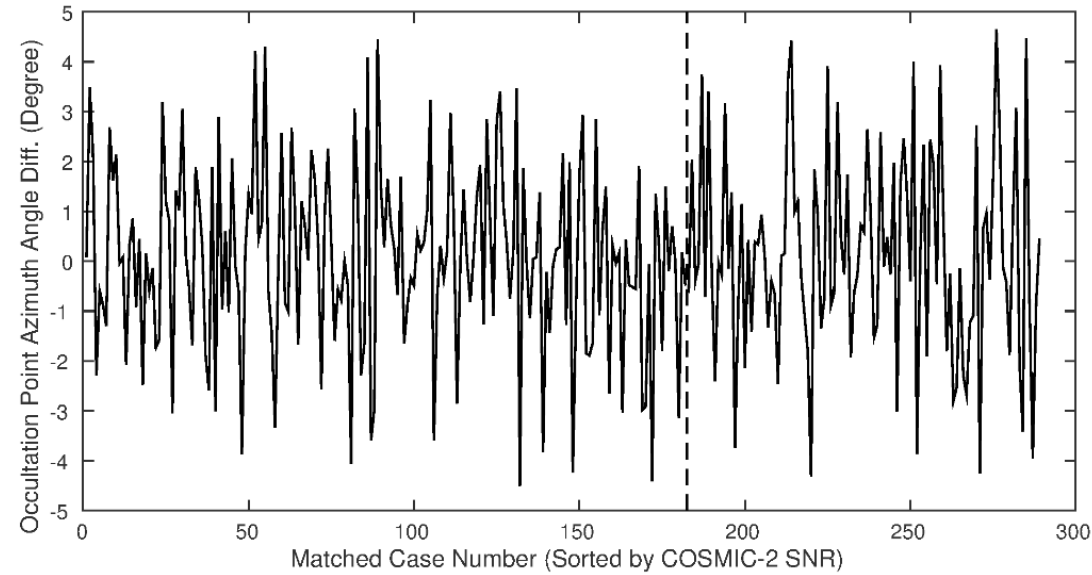
Figure 8. Occultation point azimuth angle difference for the SRO pairs between COSMIC-2 and GeoOptics. Note that the SRO cases are sorted by the averaged signal-to-noise ratio (SNR) between 60 to 80 km from COSMIC-2 and are separated by GPS (from index 1 to 182) and GLONASS (from index 183 to 289), indicated by the vertical dashed line.